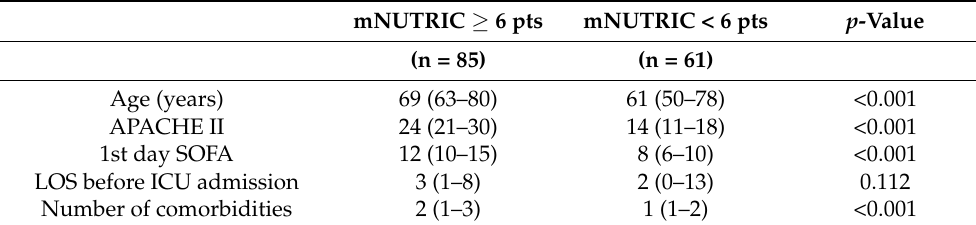
Table 3. Analysis of the variables used to calculate the mNUTRIC